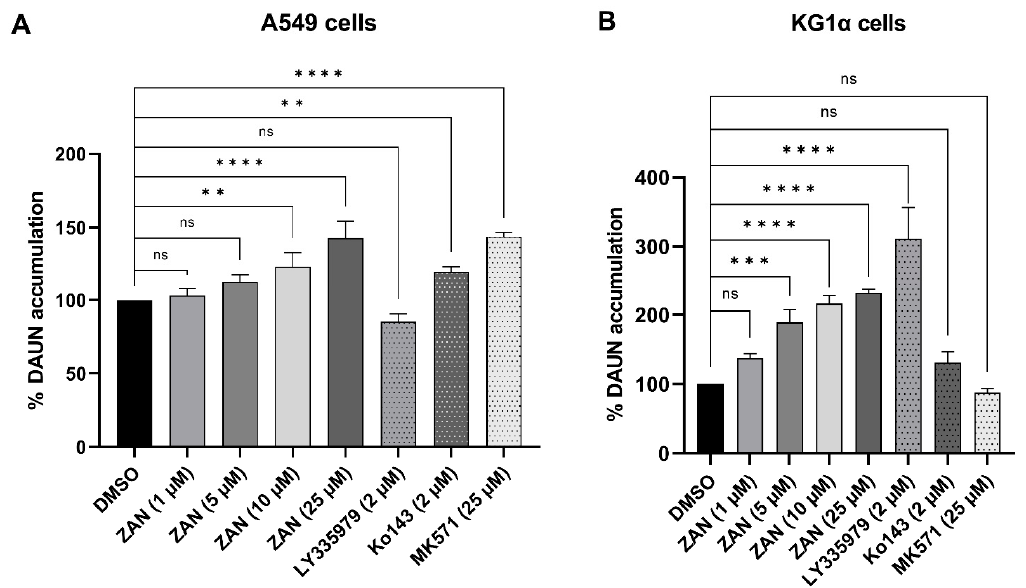
Figure 4. Zanubrutinib (ZAN) counteracts daunorubicin (DAUN) resistance in A549 cells. ( A ) A549 cells were treated with dimethyl sulfoxide (DMSO) (a vehicle) or ZAN (1 and 5 µ M) and increasing concentrations of DAUN (0.01–1 µ M), incubated for 72 h, and then cell viability was evaluated using the XTT test. GraphPad Prism 9.3.1. was used for one-way analysis of variance (ANOVA), followed by Dunnett’s post hoc test. ** p < 0.01 and **** p < 0.0001 in regards to DMSO vehicle control. 95% CI = 95% confidence interval. ( B ) Chou–Talalay analysis was performed to create the combination index (CI) vs. fraction of cells affected (F A ) plot for 1 and 5 µ M ZAN and to distinguish synergism (<0.9) from additivity (0.9–1.1) and antagonism (>1.1). The dotted line was positioned at CI = 1 for better orientation. Data are presented as mean ± standard deviation (SD) from three independent experiments.